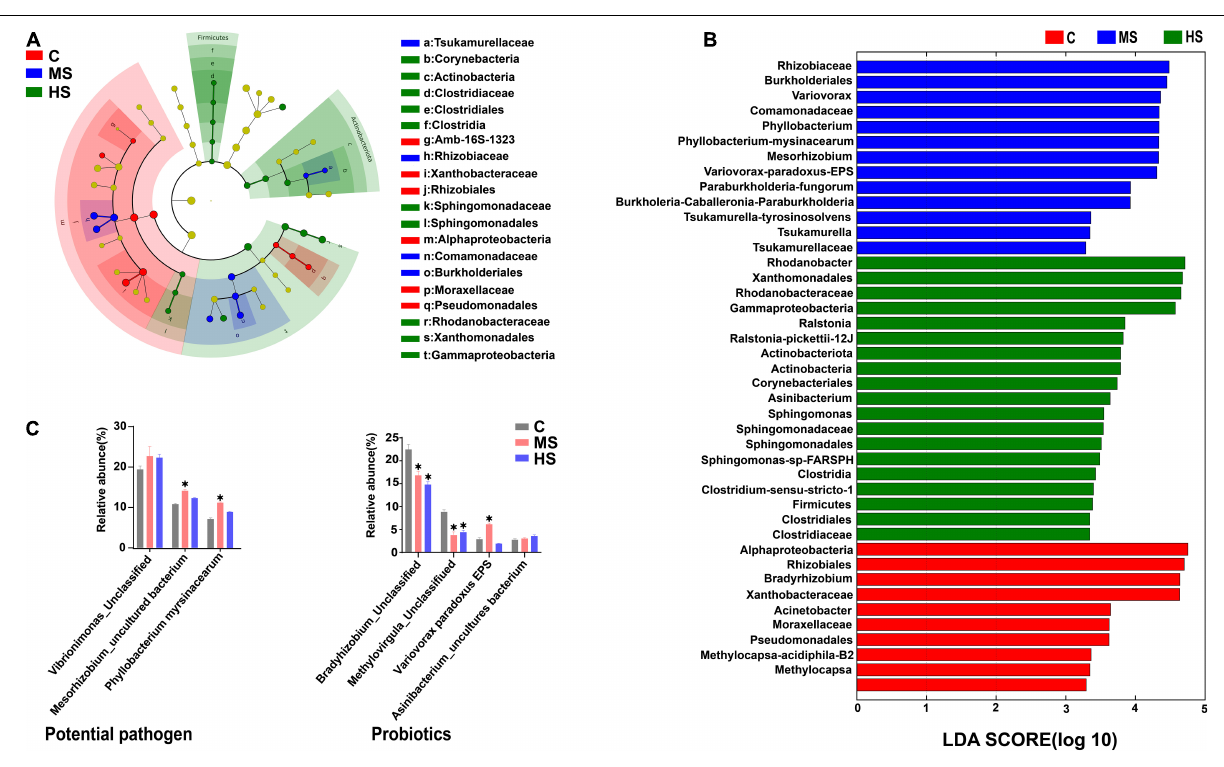
FIGURE 6 | LEfSe analysis of the differences in skin microbiota of Siberian sturgeon. (A) Taxonomic characterization of differences in skin microbiota of Siberian sturgeon under different temperature treatments, the concentric circles from the inside to the outside stand for different taxonomic classes (phylum to family). Different color areas point to different groups (the red nodes in the branches represented microbial taxa that play an important role in the control group, the blue nodes indicate microbial taxa that plays a vital role in the MS group, the green nodes mean microbial taxa that play a key role in the HS group, while the yellow nodes show no significant difference). Abundance of skin microbiota were revealed by the size of each node. (B) Linear discriminant analysis (LDA) for three groups, scores for remarkable abundant of skin microbiota. (C) The relative proportion of species under different temperatures, only classes that are present at abundances > 1% in at least one sample are shown. * p < 0.05, indicates a significant difference compared to the group